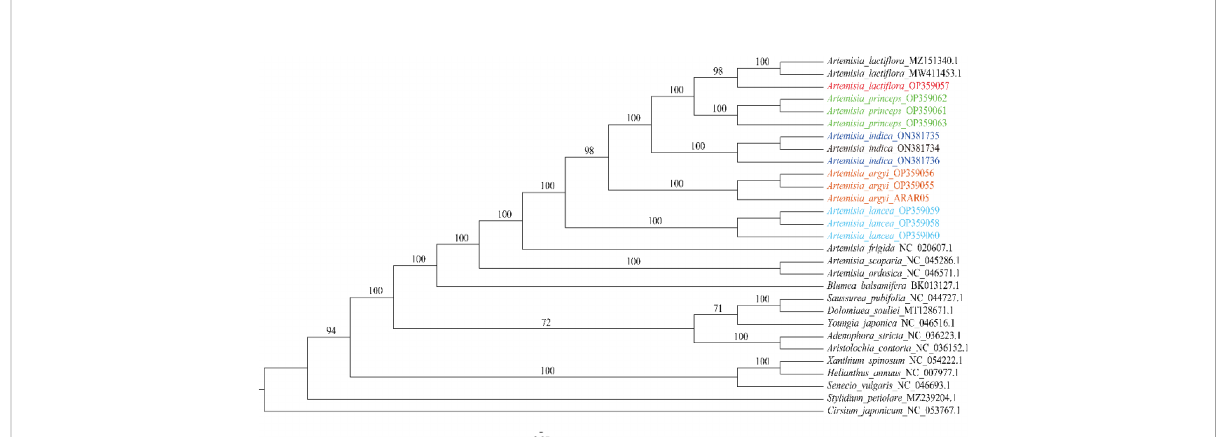
FIGURE 5 Phylogenetic tree constructed using the ML method based on the 29 cp genomes from 19 species. The numbers above the branches represent the ML bootstrap values. ML, maximum